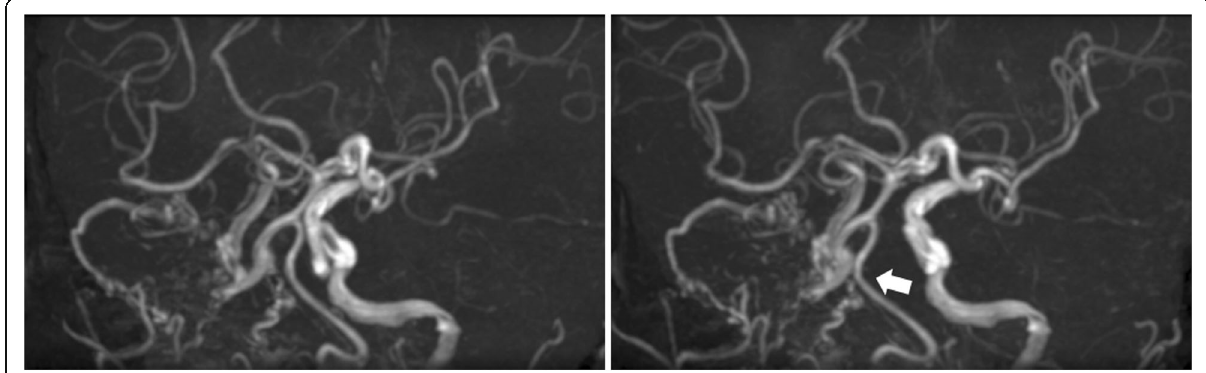
Fig. 2 Magnetic resonance angiography. Stereoscopic images of 3D time-of-flight magnetic resonance angiography showing segmental agenesis of the right internal carotid artery (ICA). The ipsilateral primitive trigeminal artery supplies the distal segments of the ICA and the dysplastic ipsilateral vertebral artery (VA). The arrow indicates the VA